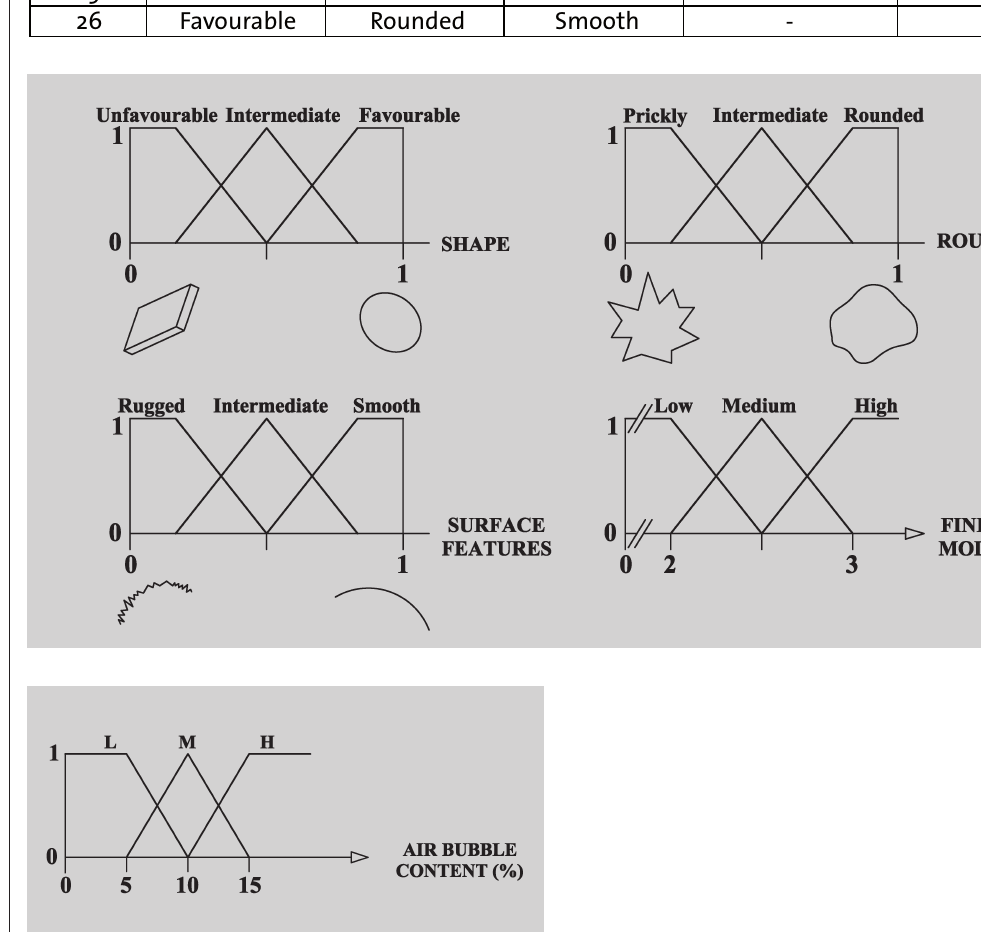
Table 2: Rules of the knowledge base for estimating the “sand rheo-index”, SRI, see Figs. 9 – 10, (L low, M medium, MD moderate, MM median, H high). Figure 10 (middle): Membership functions of the SRI independent vari- ables. Figure 11 (below): LOW, MEDIUM, HIGH: membership functions of air bubble